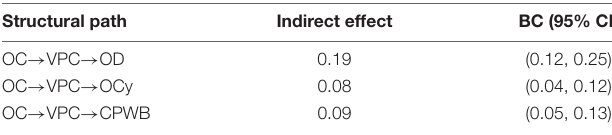
TABLE 4 | Mediation